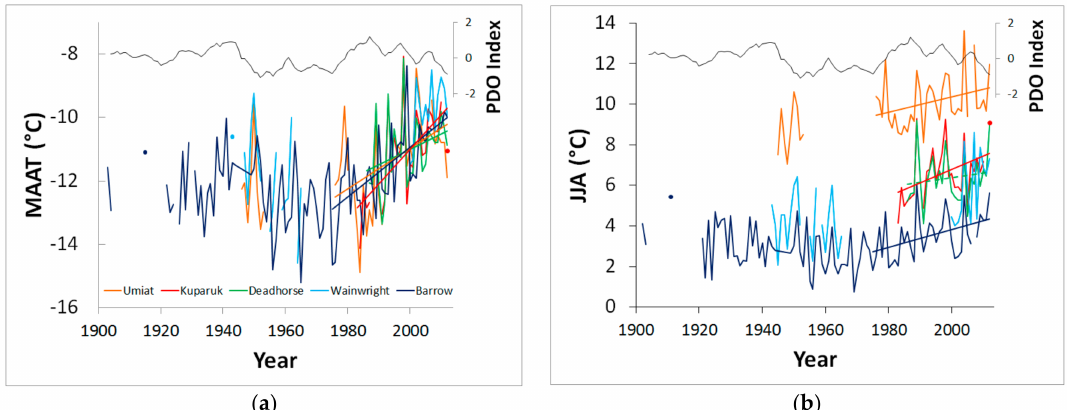
Figure 6. Mean annual air temperature (MAAT; a ) and mean June–August air temperature (JJA; b ) records for North Slope meteorological stations, 1901–2012. Each plot also displays the 5-year running average of the Pacific Decadal Oscillation Index. Discontinuities exist in the record for most stations; circles denote isolated years with data. Trendlines indicate statistically significant linear trends ( p < 0.05) recorded at stations since